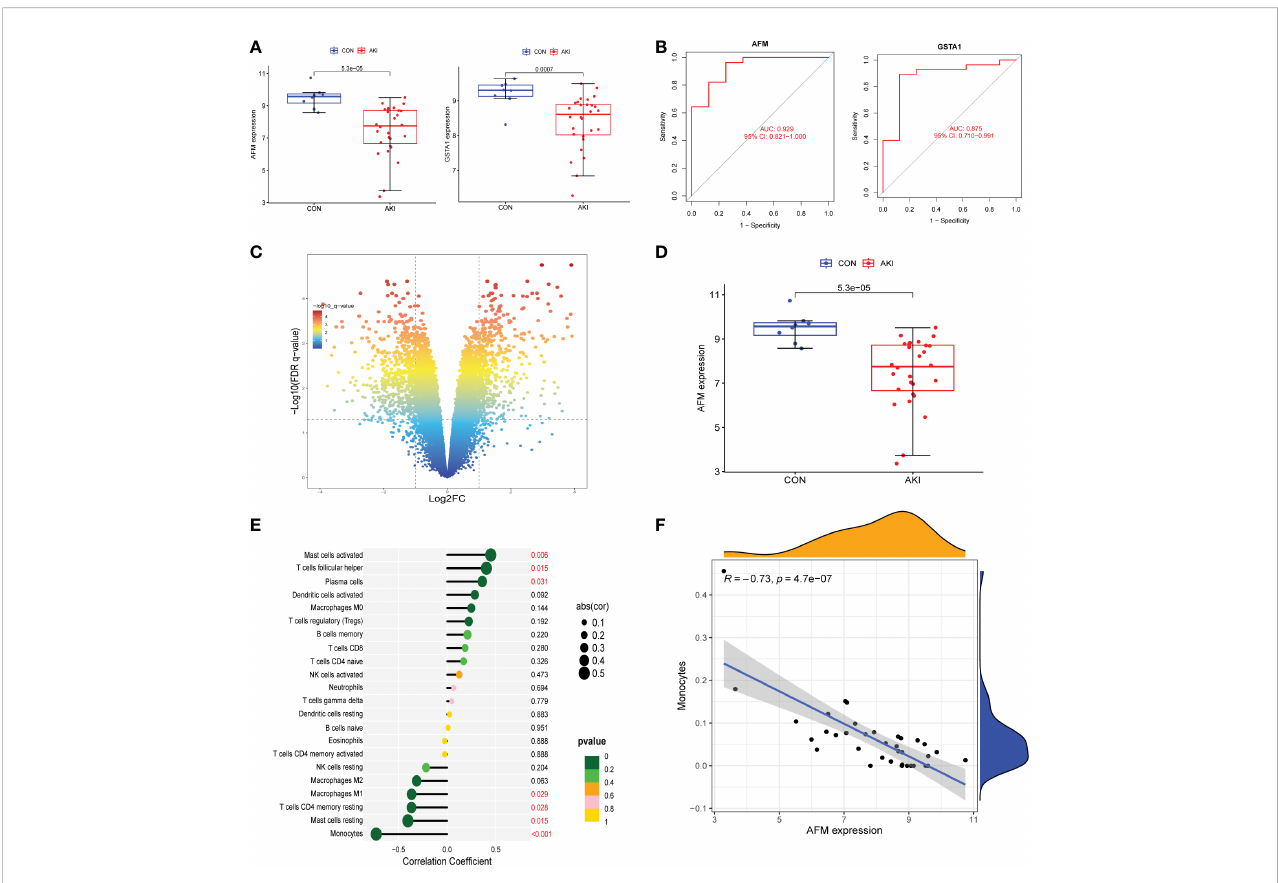
FIGURE 5 (A) The expression of AFM and GSTA1 were high in the AKI group in the GSE30718 dataset. (B) ROC curves for AFM, GSTA1. (95% con fi dence interval (CI), AFM: 0.817-1.000; GSTA1: 0.714-0.996.) (C) The volcano plot showing the differential gene expression (fold change ≥ 1; FDR<0.05) between control and AKI group in GSE44925 dataset. (D) The expression of AFM and GSTA1 were high in the AKI group in the GSE44925 dataset. (E) The relationship between AFM expression and immune cell in fi ltration level; P < 0.05 was considered statistically signi fi cant. (F) Scatter plot of AFM expression versus level of monocyte in fi ltration.